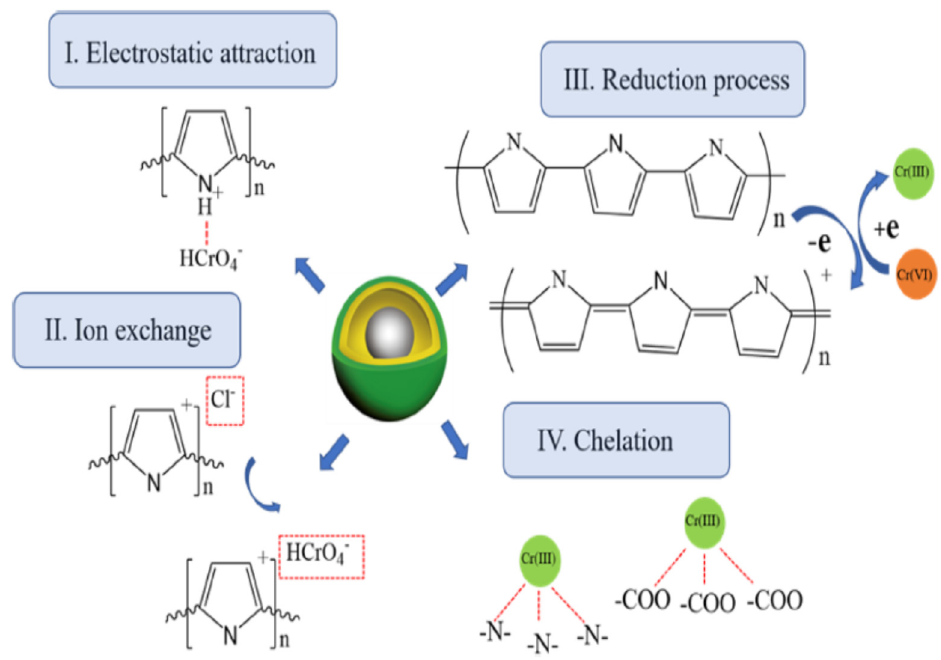
Figure 6. Possible adsorption mechanism of Cr (VI) removal by magnetic-UiO66-Ppy. Reprinted with permission from Ref. [114]. Copyright 2021 Springer Nature.